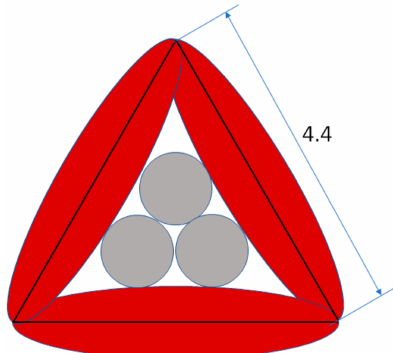
Figure 9. Schematic structural unit of the honeycomb arrangement observed for some systems at high packing fraction, high charge and low